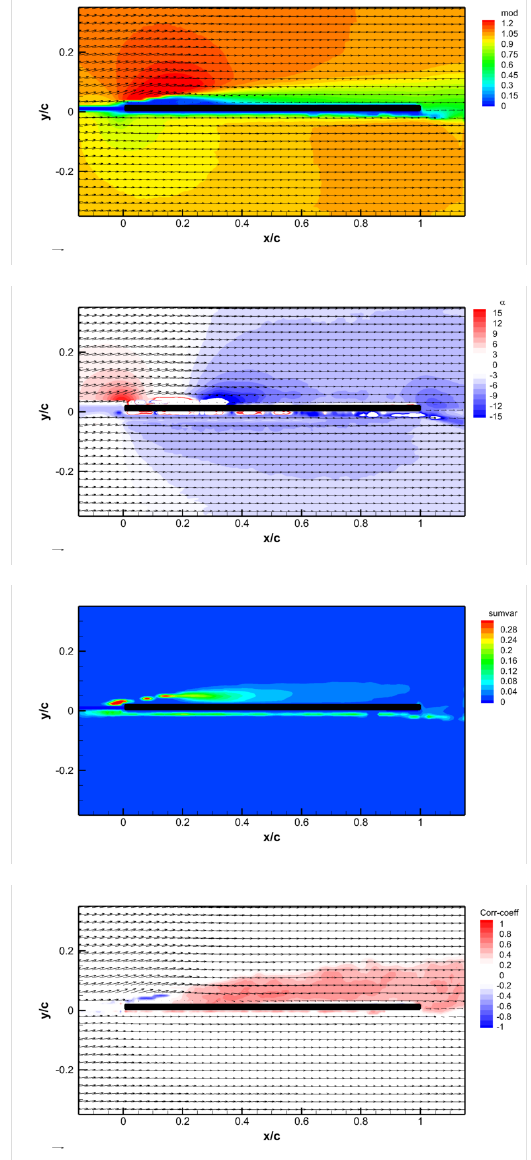
Fig. 2. Mean velocity, down-wash angle, TKE and correlation coefficient distributions, whole airfoil